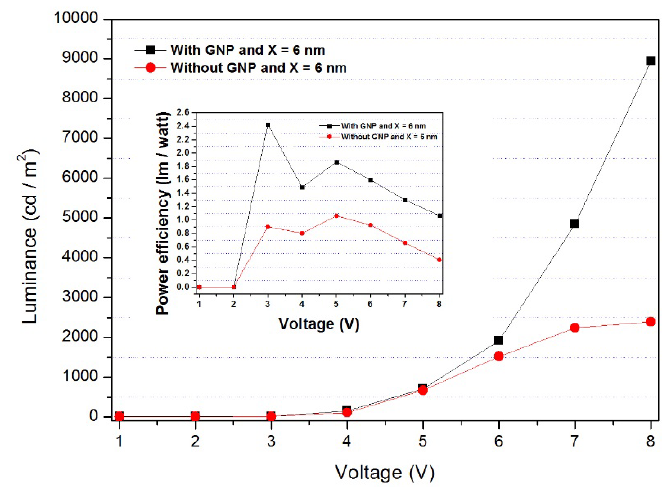
Figure 5. Luminance-voltage curves of devices with and without GNPs when the thickness of the NPB is 6 nm and the inset figure shows the power efficiency-voltage characteristics of the device under the same conditions.